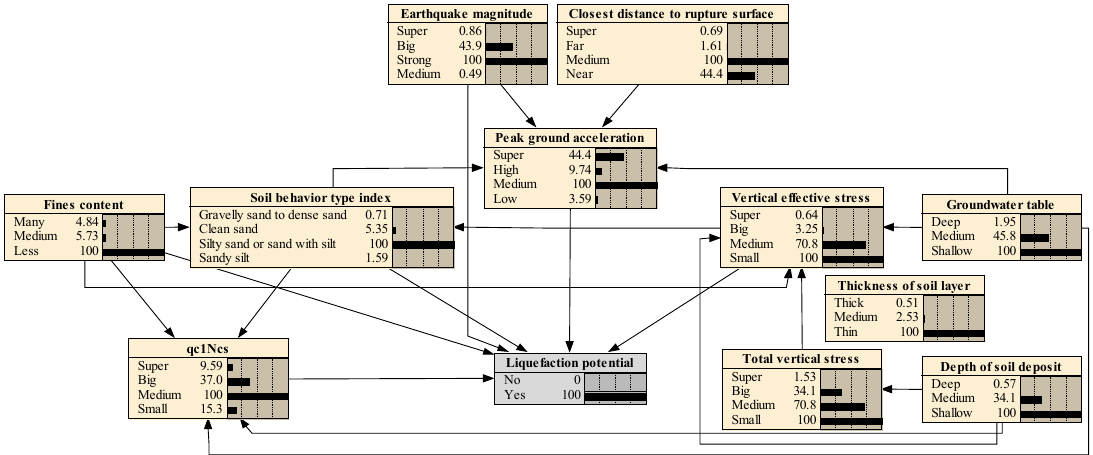
Figure 8. The most probable explanation of liquefaction potential when the evidence state is “yes.”